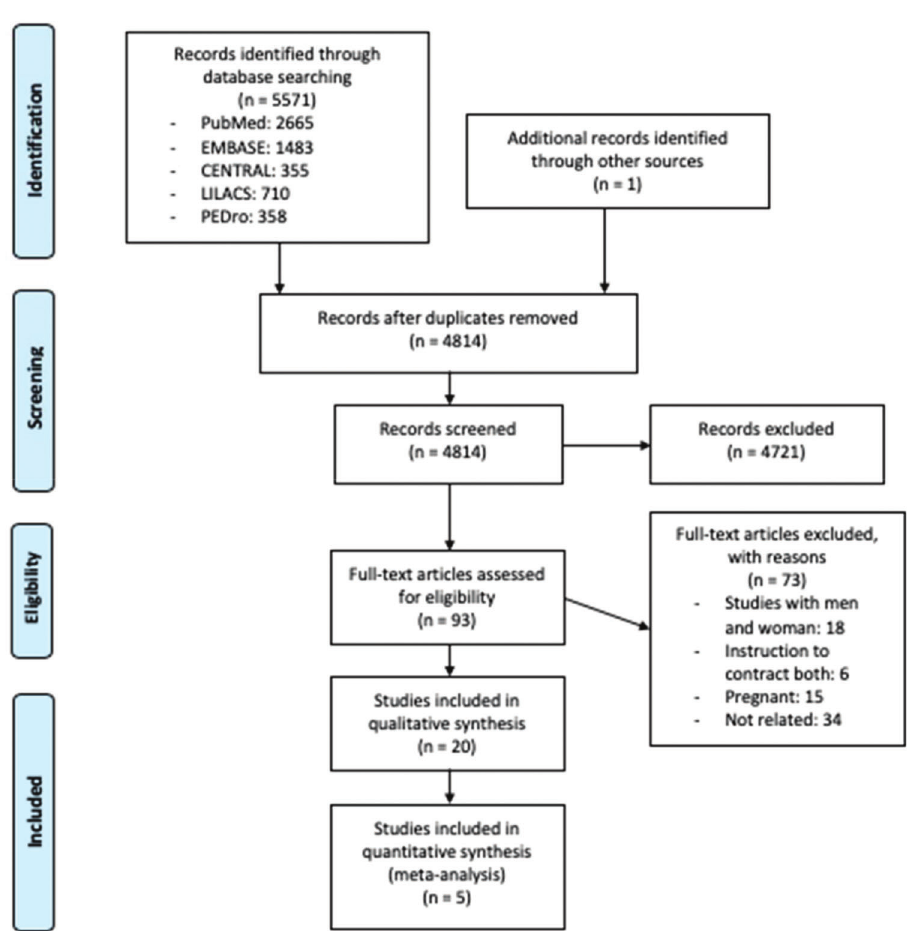
Figure 1 - Flowchart of the studies included in this